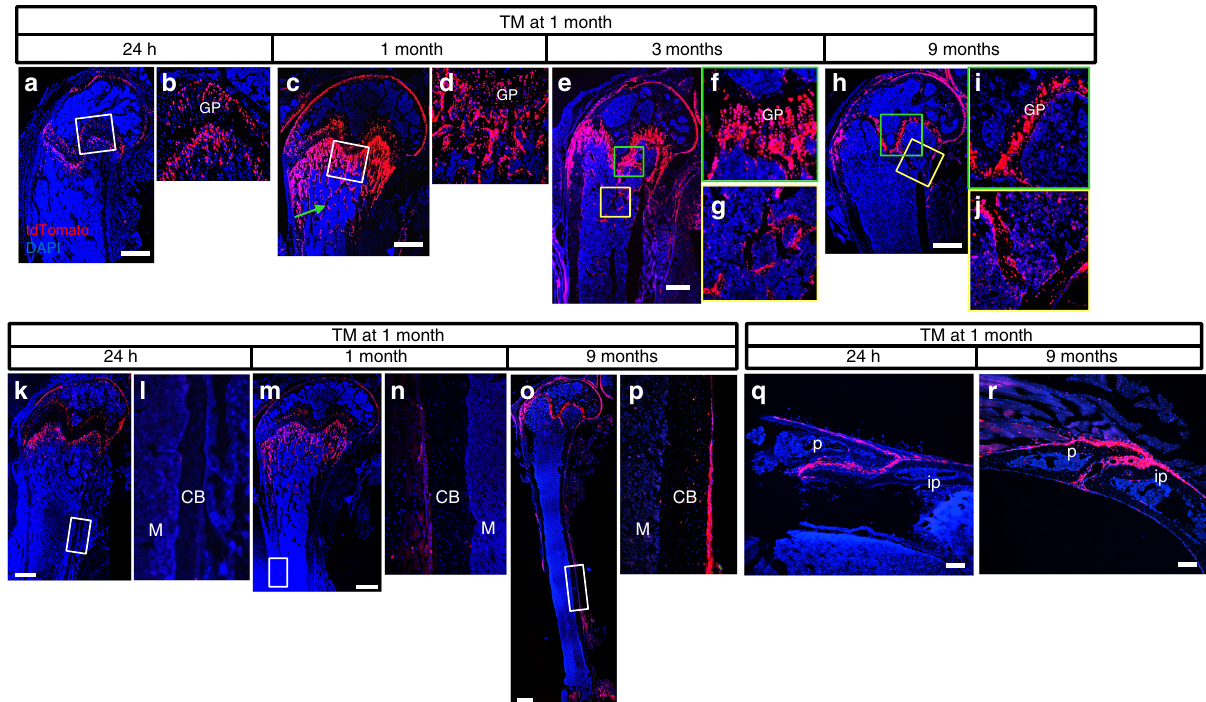
Fig. 2 Postnatal Gli1 + cells contribute to osteoblasts in both endochondral and intramembranous bones. Gli1-CreER T2 ; Ai9 mice were treated with TM at 1 month of age and analyzed at 24 h a , b , k , l , q ; 1 month c , d , m , n ; 3 months e – g ; or 9 months h – j , o , p , r after the last TM dosing. Representative images from three mice for each time point are presented. Red: tdTomato + cells; blue: nuclear staining by DAPI. Scale bars: 500 µ m a – o or 100 µ m q , r . a – p Representative confocal images of frozen sections of the femur. Boxed areas are shown at a high magni fi cation in corresponding panels to the right. GP growth plate. Green arrow: trabecular bone. CB cortical bone, M marrow. q , r Representative confocal image showing sections through the lambdoid